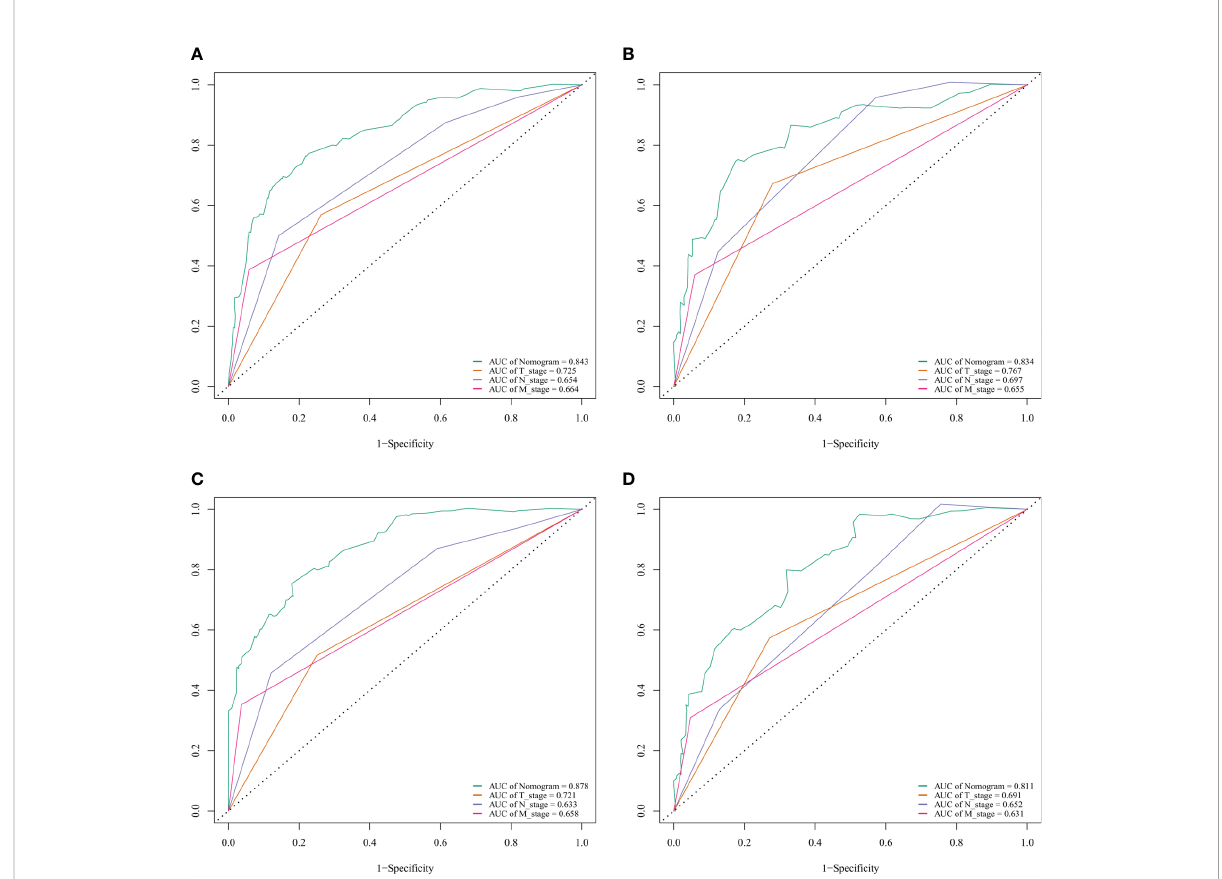
FIGURE 4 ROC curves for predictions of cancer-speci fi c survival (CSS) in the training cohort at 5 and 10 years. ROC curves of the nomogram and AJCC T-, N-, and M-stage in training ( A , 5-year; C , 10-year) and validation ( B , 5-year; D , 10-year) cohorts. AJCC, American Joint Committee on Cancer; AUC, areas under the ROC curve; ROC, receiver operating characteristic curve; TNM, tumor – node –